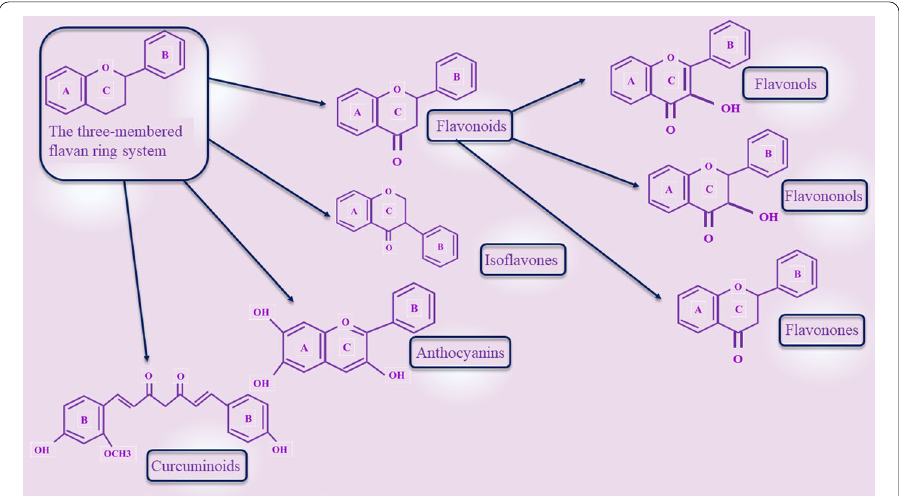
Fig. 1 Schematic representation of different structures of polyphenols. These agents have a three-membered flavan ring system in